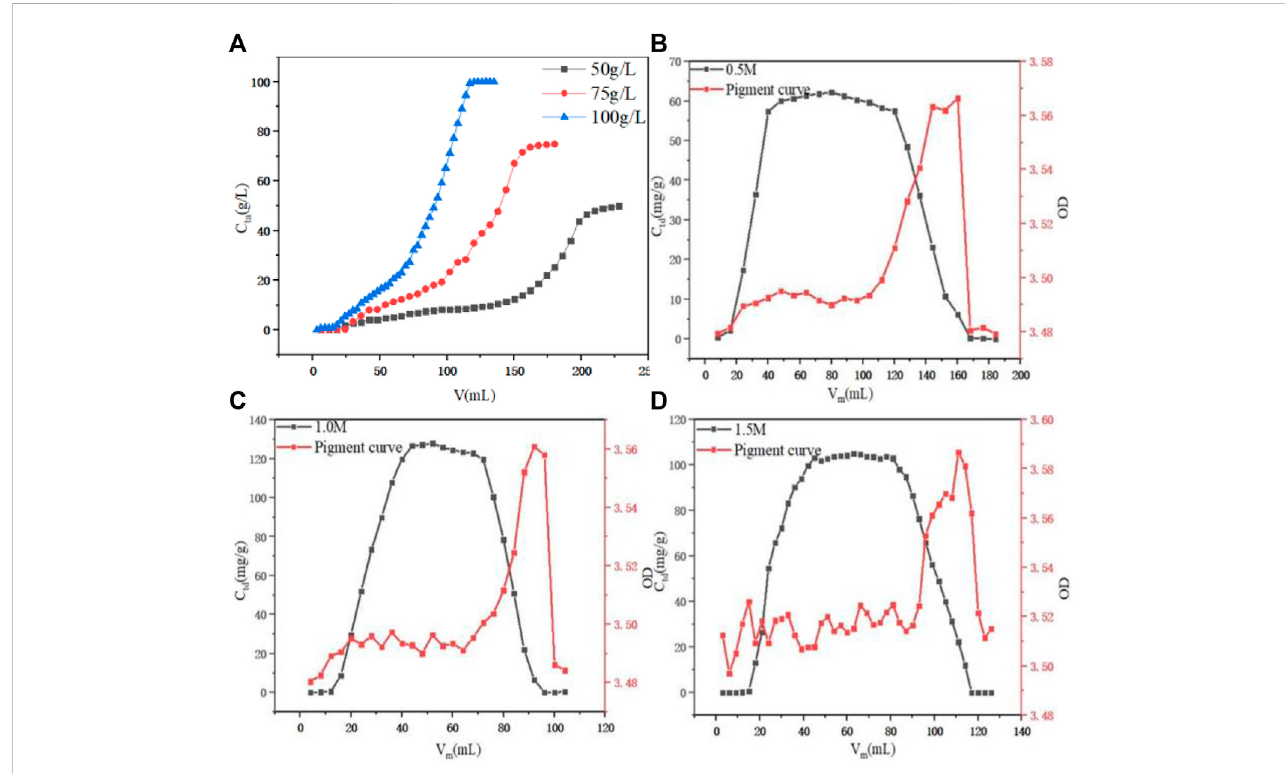
FIGURE 7 (A) Effect of initial PDA concentration on dynamic adsorption. (B) Effect of initial 0.5 M HCl on dynamic desorption. (C) Effect of initial 1.0 M HCl on dynamic desorption. (D) Effect of initial 1.5 M HCl on dynamic